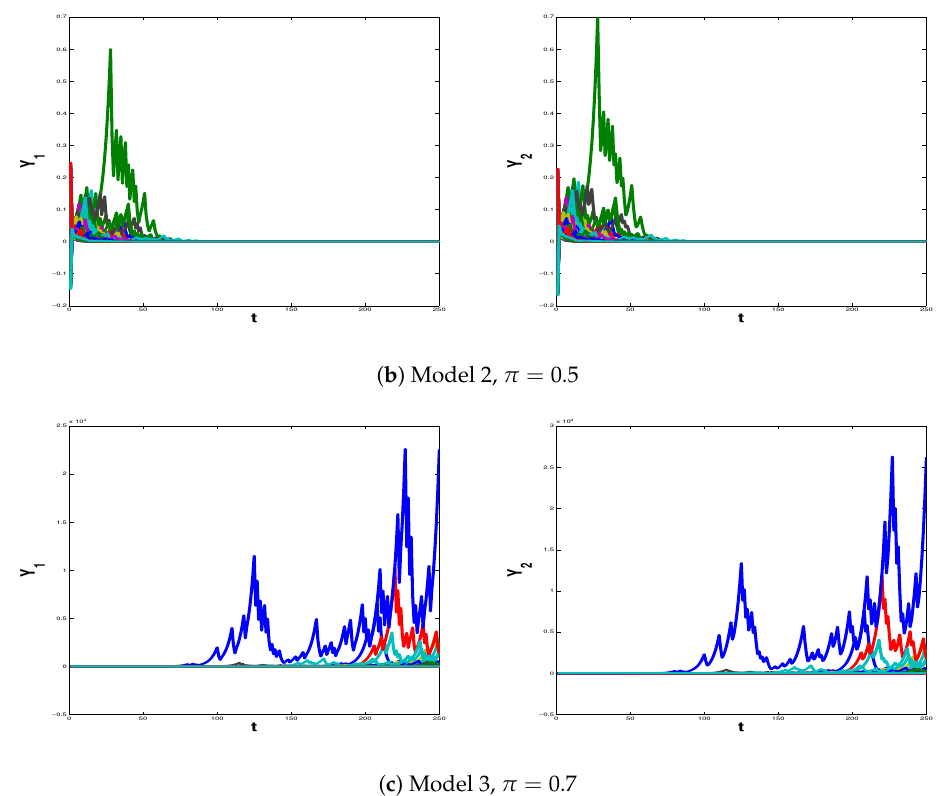
Figure 1. Simulated paths represented by different colors from models 1–3 for different set of histories over a n = 250 period using m = 200 simulated paths. The parameters are those from Table 1 and the probability to be in the explosive regime 2 is equal to π